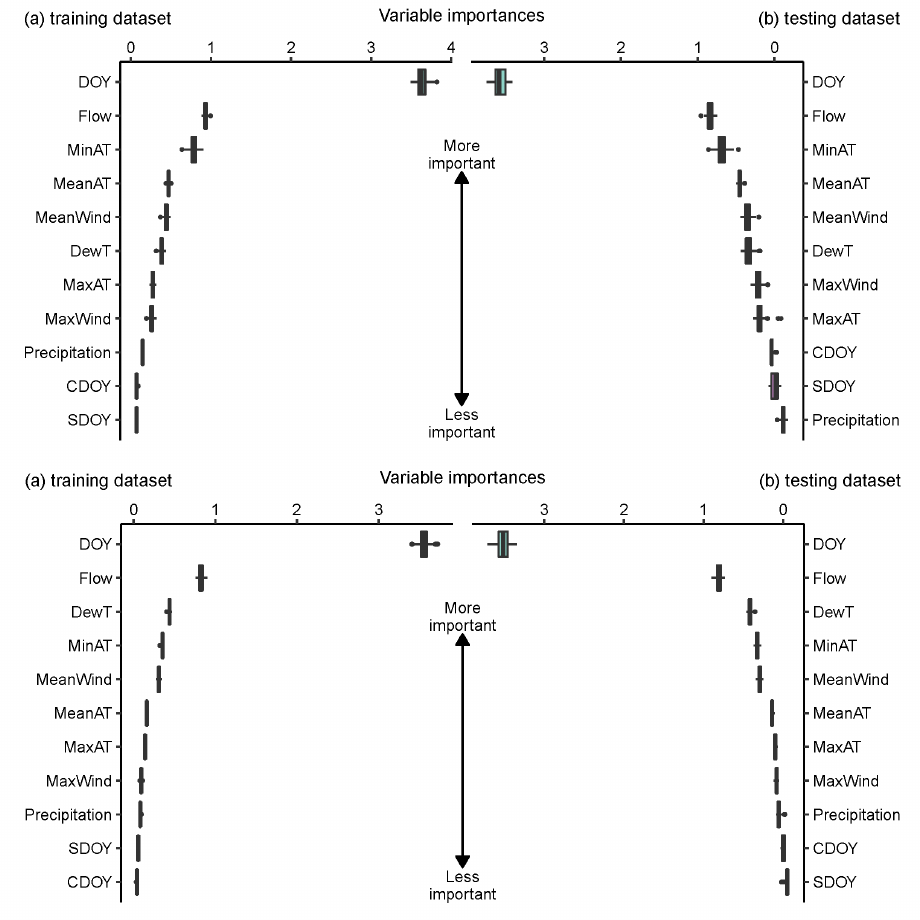
Figure 4. Permutation importance in DT and RF; DT, decision trees, RF, random forests. (DT on the top , RF on the bottom , WT: ◦